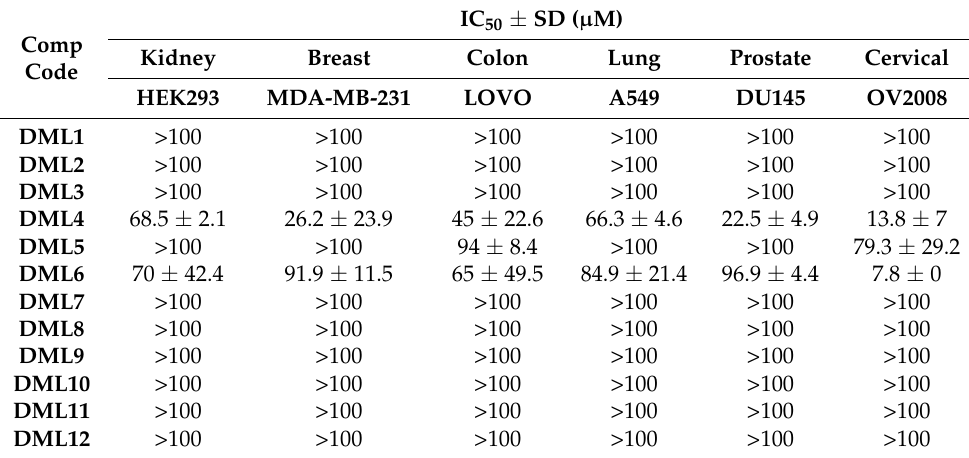
2.2. Structure–Activity Relationships for the Dialkylamine Substituted Chalcones and Their Corresponding Dihydropyrazoles, Based on Data Obtained Using the 3-(4,5-Dimethylthiazol-2- yl)-2,5-diphenyltetrazolium Bromide (MTT) Cytotoxicity Assay All of the synthesized compounds ( DML1 to DML12 ) were evaluated to determine their in vitro antiproliferative efficacy in cervical (OV2008), breast (MDA-MB-231), lung (A549), colon (LOVO), prostate (DU145) and the normal cell lines, human embryonic kidney cells (HEK293), human colon fibroblast cells (CRL1459) and Chinese hamster ovary cells (CHO), using the MTT assay. The newly synthesized compounds were tested at concentrations from 0.1 to 100 µ M. The concentration of the tested compounds that produced a 50% inhibition of cell growth (IC 50 ) was determined. The calculated IC 50 values of compounds tested in cancer cell lines are shown in Table 2. Table 2. The antiproliferative efficacy of the DML1 – DML12 compounds on the proliferation of cancer cell lines (breast, colon, lung, prostate and cervical) and a normal, non-cancerous cell line,